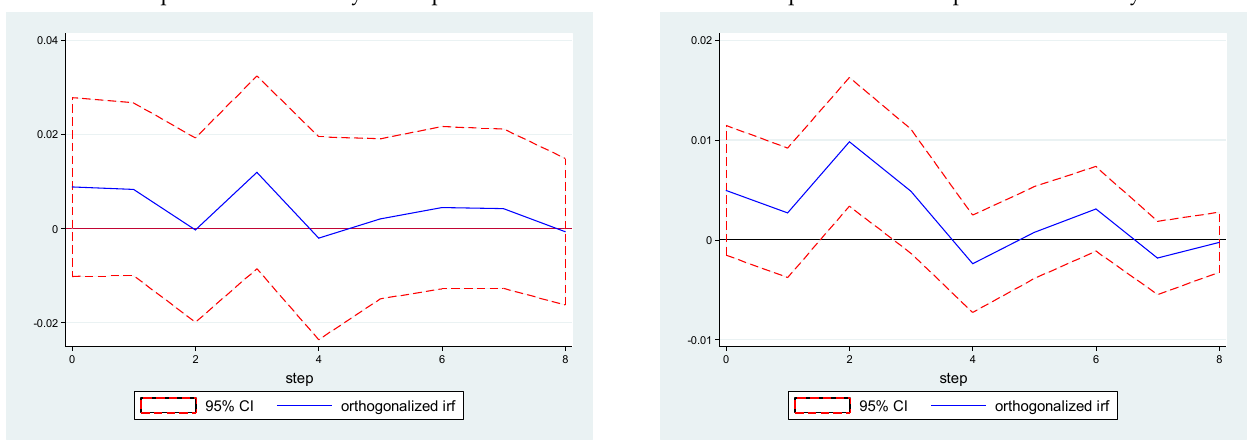
Figure 4. Impulse Response of lnCurrency1 to Expect and Shortcapital to lnCurrency1.